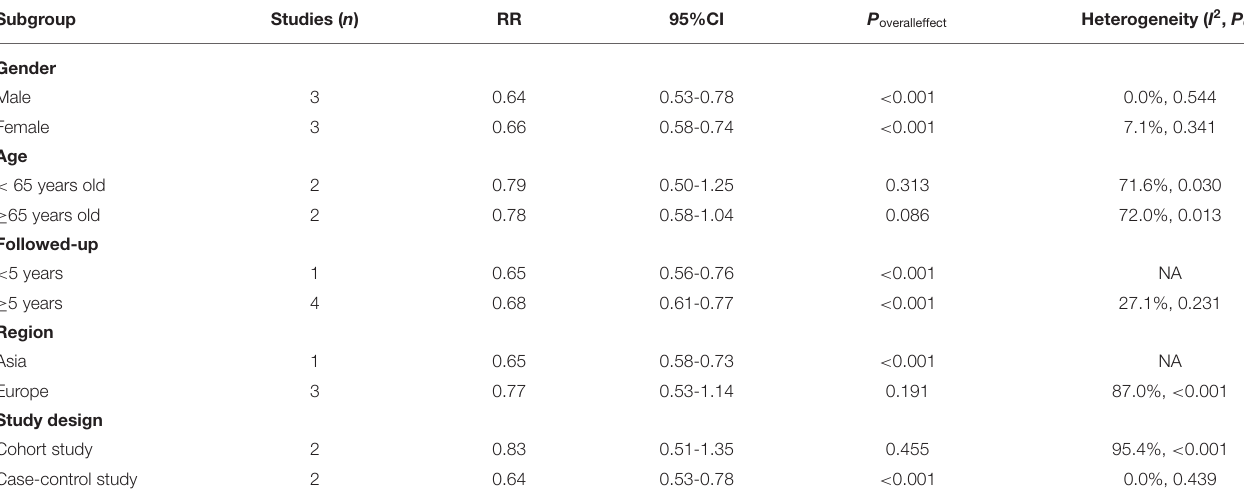
TABLE 3 | Stratified analysis of the association between rheumatoid arthritis and Parkinson’s disease. Subgroup Studies ( n